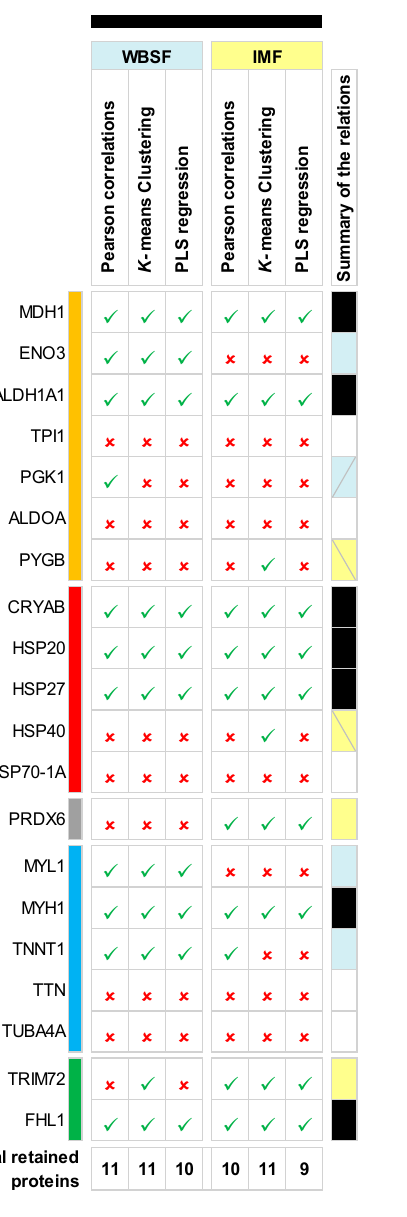
Figure 4. Summary of the evaluation of the 20 protein biomarkers quantified by RPPA using the three statistical methods (Pearson correlations, k -means clustering and Partial Least Squares regressions (PLS-R)) to explain / predict WBSF and IMF content on the Longissimus thoracis muscle of the 188 PDO Maine-Anjou cows.